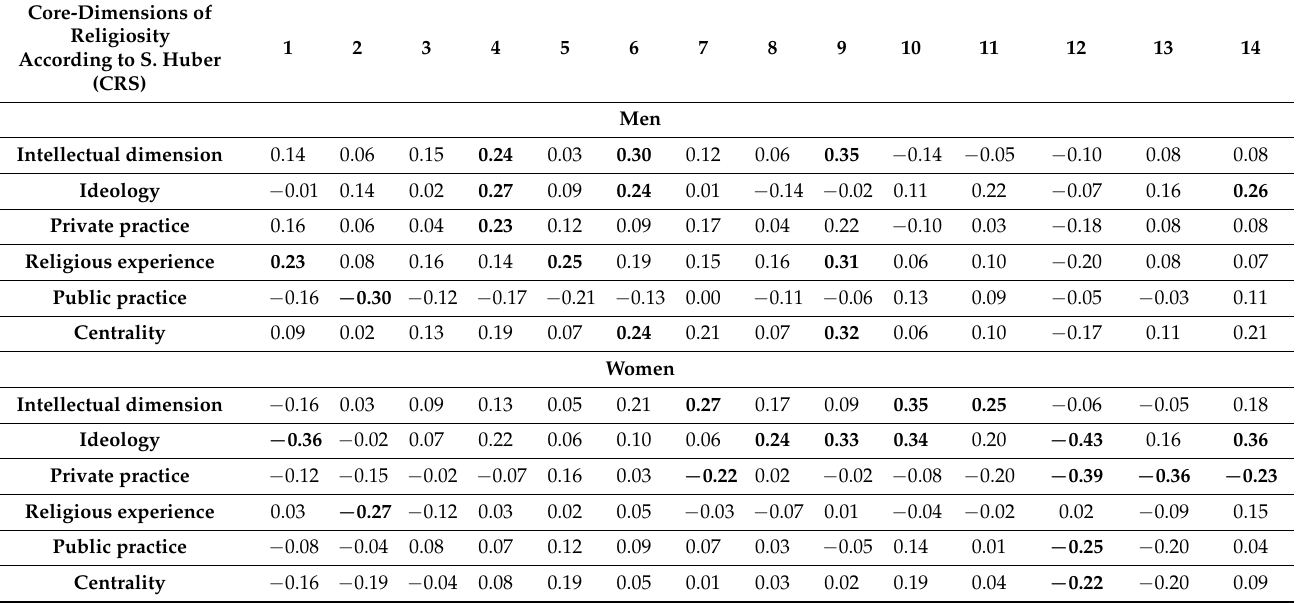
Table 4. The value of correlation (r) between the respondents’ religiosity and their opinions on marriage, taking into account the variable of